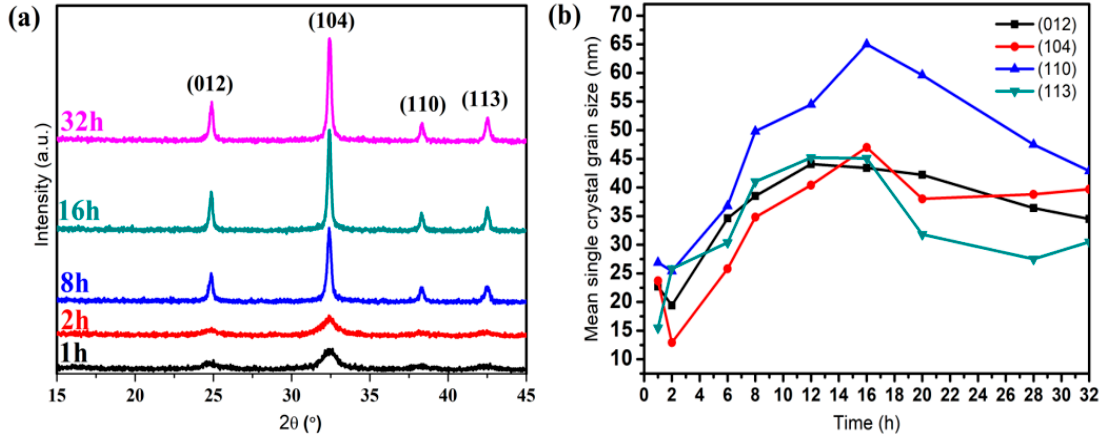
Figure 5. ( a ) XRD scan of the prepared CoCO 3 under different crystallization times. ( b ) Average crystal size of different facet orientations ((012), (104), (110), (113)).